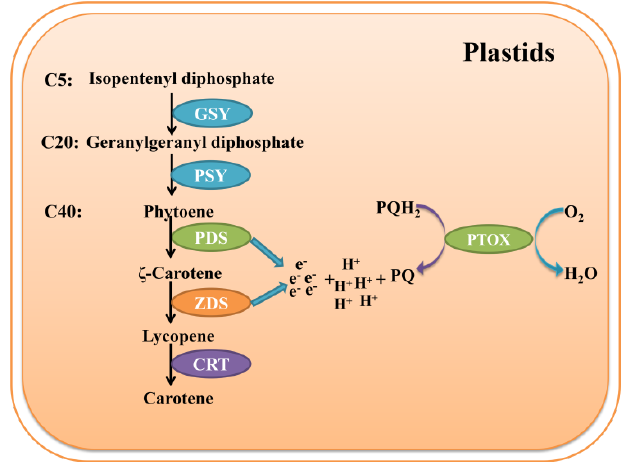
Figure 1. PTOX participates in the process of carotenoid metabolism in plant plastids [9,14,21]. PTOX, plastid terminal oxidase; PQ, plastoquinone; PQH 2 , reduced plastoquinone; GSY, geranylgeranyl pyrophosphate synthase; PSY, phytoene synthase; PDS, phytoene desaturase; ZDS, zeta-carotene desaturase; CRT, carotenoid isomerase.